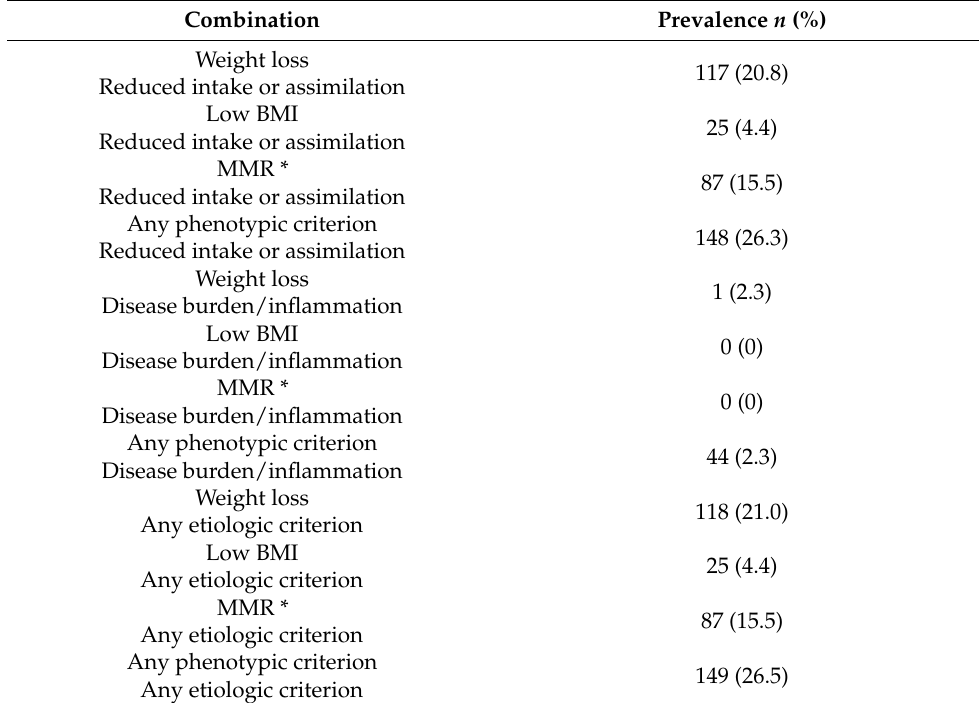
Table 3. The prevalence of malnutrition diagnosed by different combinations of phenotypic and etiologic criteria of the GLIM